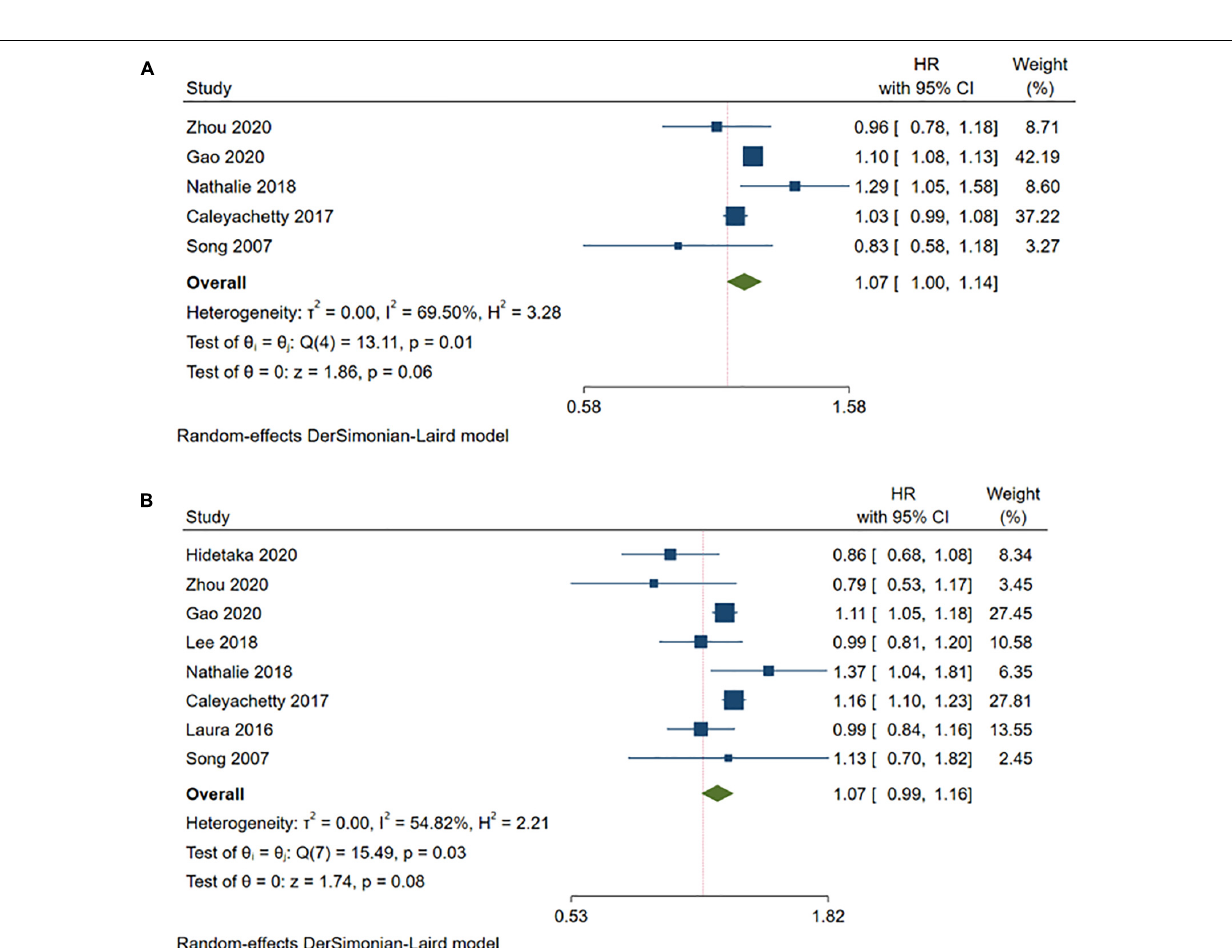
Frontiers in Cardiovascular Medicine |